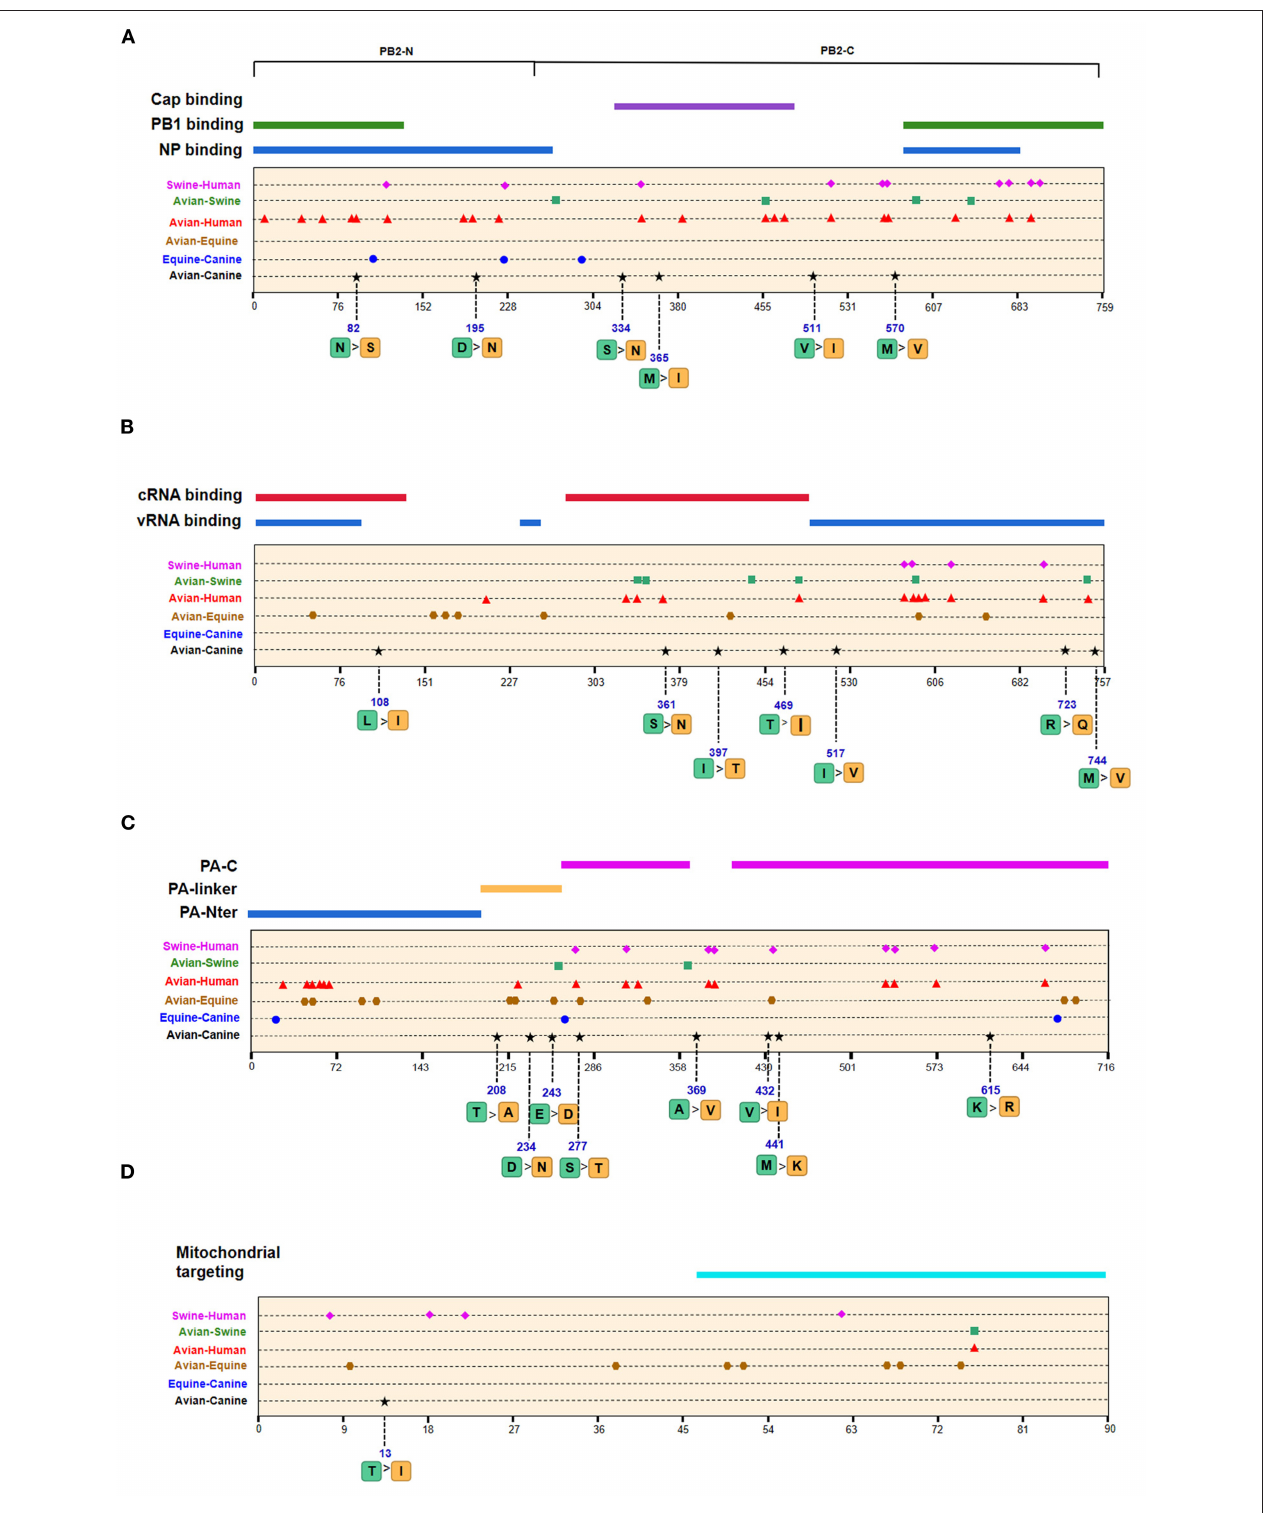
FIGURE 4 | Positions of identified signatures in the structural and functional domains of PB2 (A) , PB1 (B) , PA (C) , and PB1-F2 (D) proteins. The positions and dominant amino acid residues of Avian → Canine (H3N2) signatures are placed below the pale-yellow bar. Black star: Avian → Canine (H3N2), blue circle: Equine → Canine (H3N8), brown hexagon: Avian → Equine (H3N8), red triangle: Avian → Human (H3N2), green square: Avian → Swine (H3N2), and purple triangle rhomb: Swine → Human (H3N2). The detail of these signatures are in Table 2 .